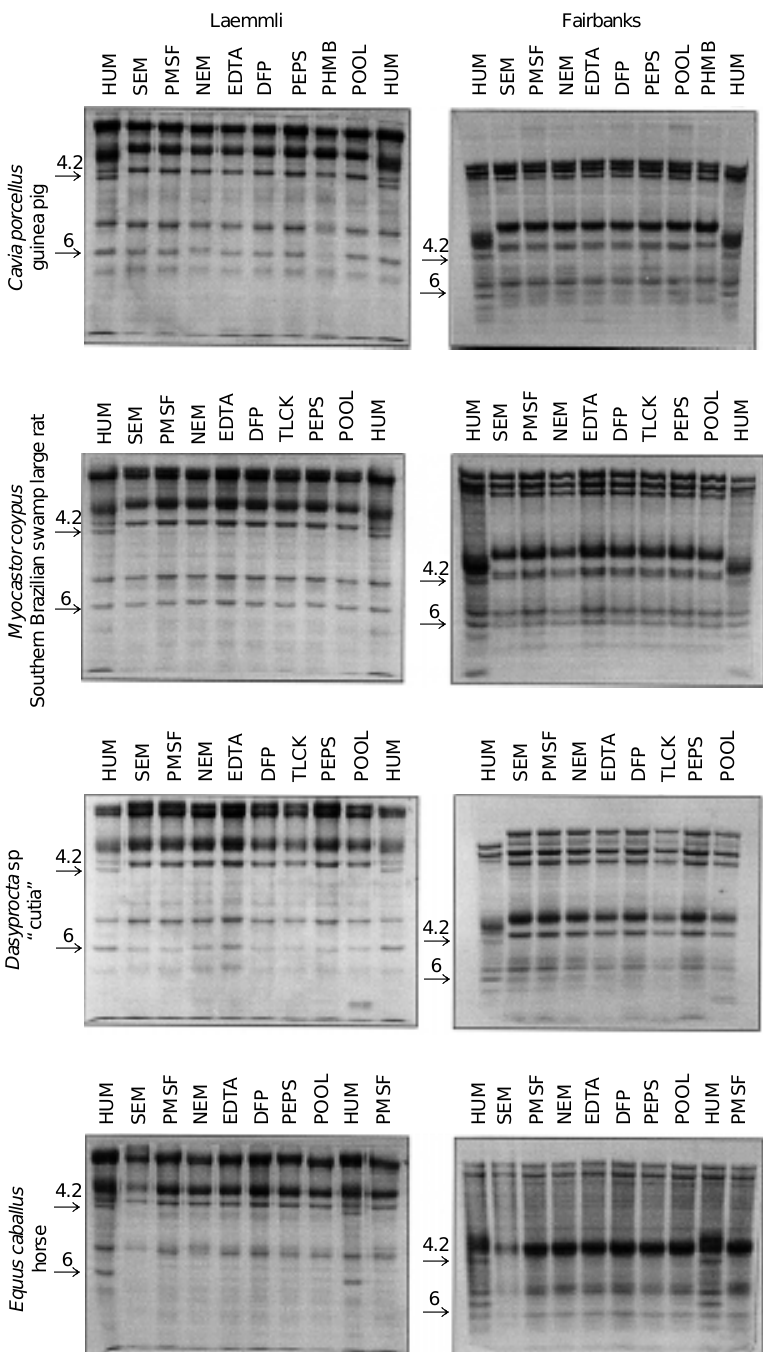
Figure 1 - Absence of erythrocyte membrane protein 4.2 in Cavia porcellus , Myocastor coypus , Dasyprocta sp and Equus caballus in SDS-PAGE. HUM, Human erythrocyte mem- brane protein; SEM, without any inhibitor; PMSF, phenylmethylsulfonyl fluoride; NEM, N- ethylmaleimide; EDTA, disodium ethylenediaminetetraacetate; DFP, diisopropylfluorophos- phate; PEPS, pepstatin A (isovaleryl-VaL-VaL--Sta-Ala-Sta); PHMB, p -hydroxymercuriben- zoic acid; POOL, mixture of all inhibitors; TLCK, Na-p-Tosyl-L-lysine chloromethyl